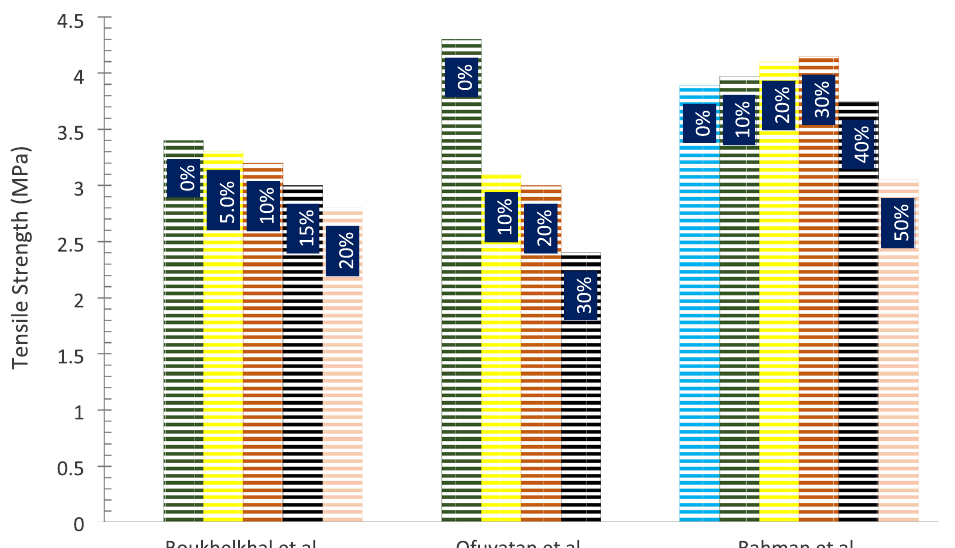
Fig. 10 Tensile strength (Boukhelkhal et al., 2017; Ofuyatan et al., 2022; Rahman et al.,